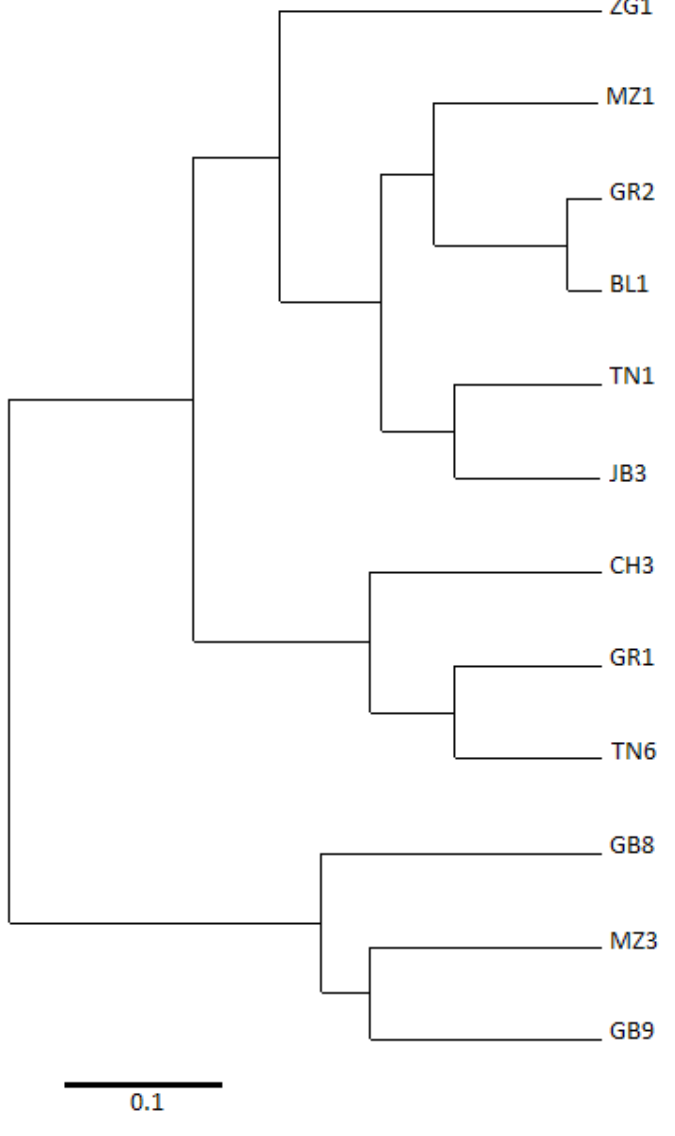
Figure 1. UPGMA dendrogram of 12 Tunisian pomegranate cultivars showing phenetic relationships of estimated from RAPD